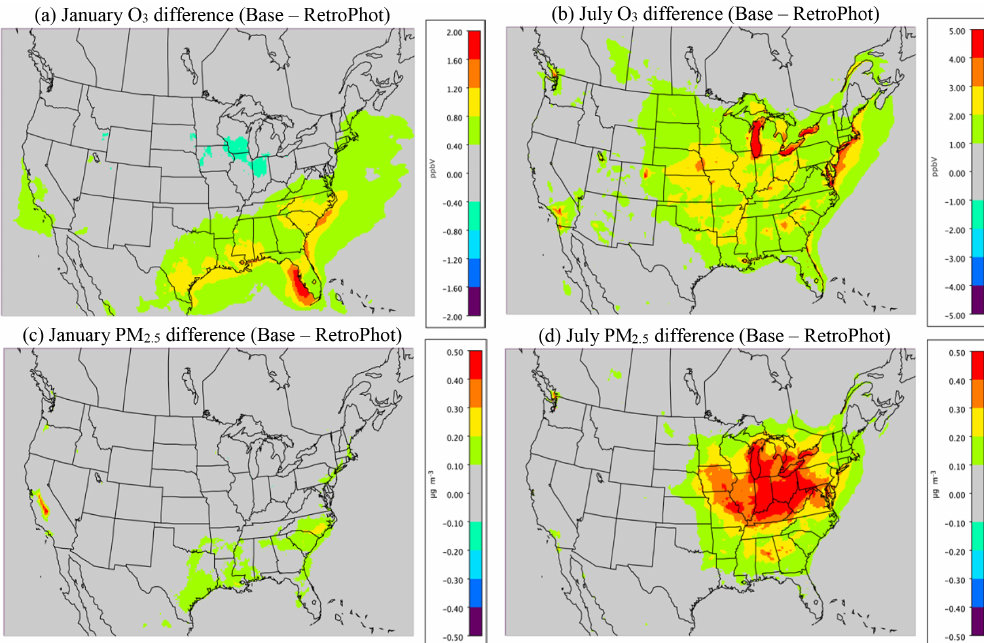
Figure 3. Difference in the monthly average O 3 for (a) January and (b) July and PM 2 . 5 for (c) January and (d) July between CMAQv5.1_base and v5.1_RetroPhot (v5.1_Base - v5.1_RetroPhot). O 3 plots are in units of parts per billion by volume (ppbv) and PM 2 . 5 plots are in units of micrograms per cubic meter (µgm − 3 ). Note that the scales between each plot may vary.